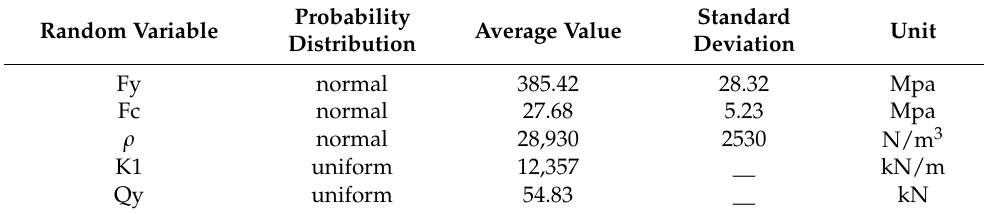
Table 1. Statistics of the random variables.